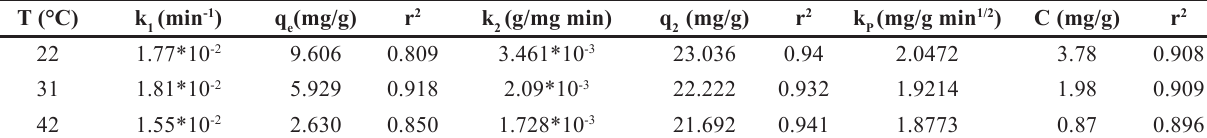
Table 5. Kinetic parameters for the adsorption of CV + onto surfactant-modified dolomite at various